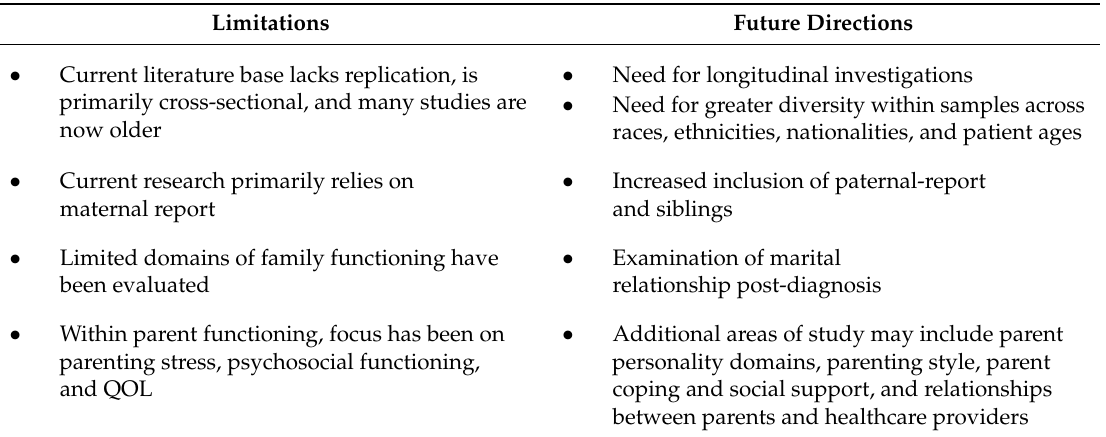
Table 1. Summary of limitations and future directions for research on parent and family functioning in pediatric